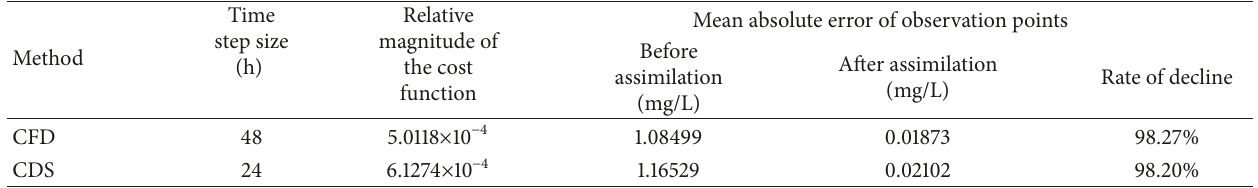
Table 5: The results of the adjoint model using CFD and CDS.